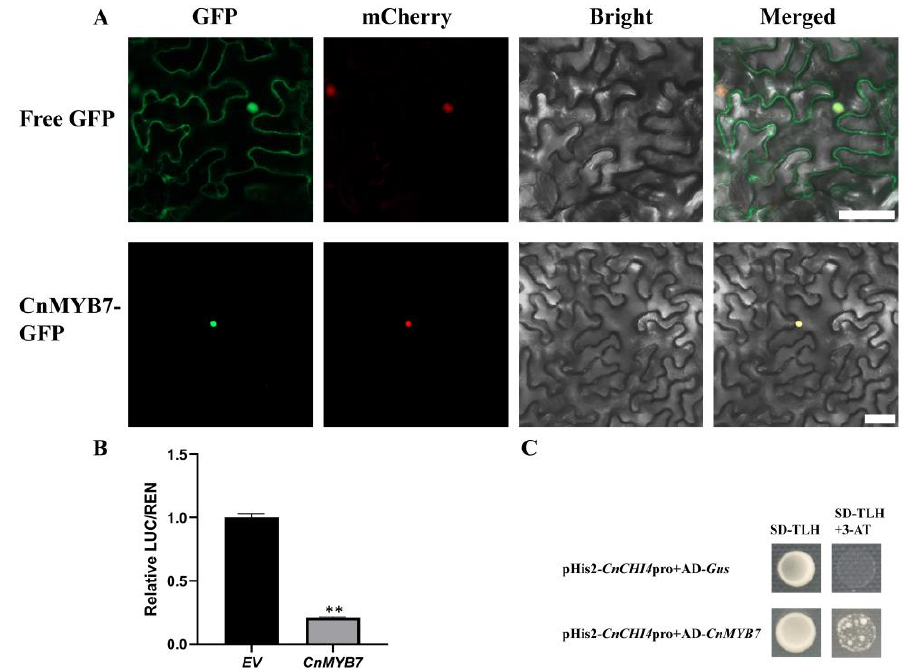
Figure 8. CnMYB7 regulates the expression of CnCHI4. ( A ) Subcellular localization of CnMYB7 protein in the leaves of N. benthamiana , co-expressed with nucleus-located mCherry. The empty vector was used as the control. GFP: images under green fluorescence channel; Bright: images under bright light; mCherry: images under red fluorescence channel; Merged: overlay plots. Bars = 50 μm. ( B ) Dual-luciferase reporter assay analyses the regulatory effects of CnMYB7 on the promoter of CnCHI4 . The SE was determined from three replicates, and statistical significance was determined by Student’s t -test (** p < 0.01). ( C ) Yeast one-hybrid analyses of the interaction between CnMYB7 and the promoter of CnCHI4.